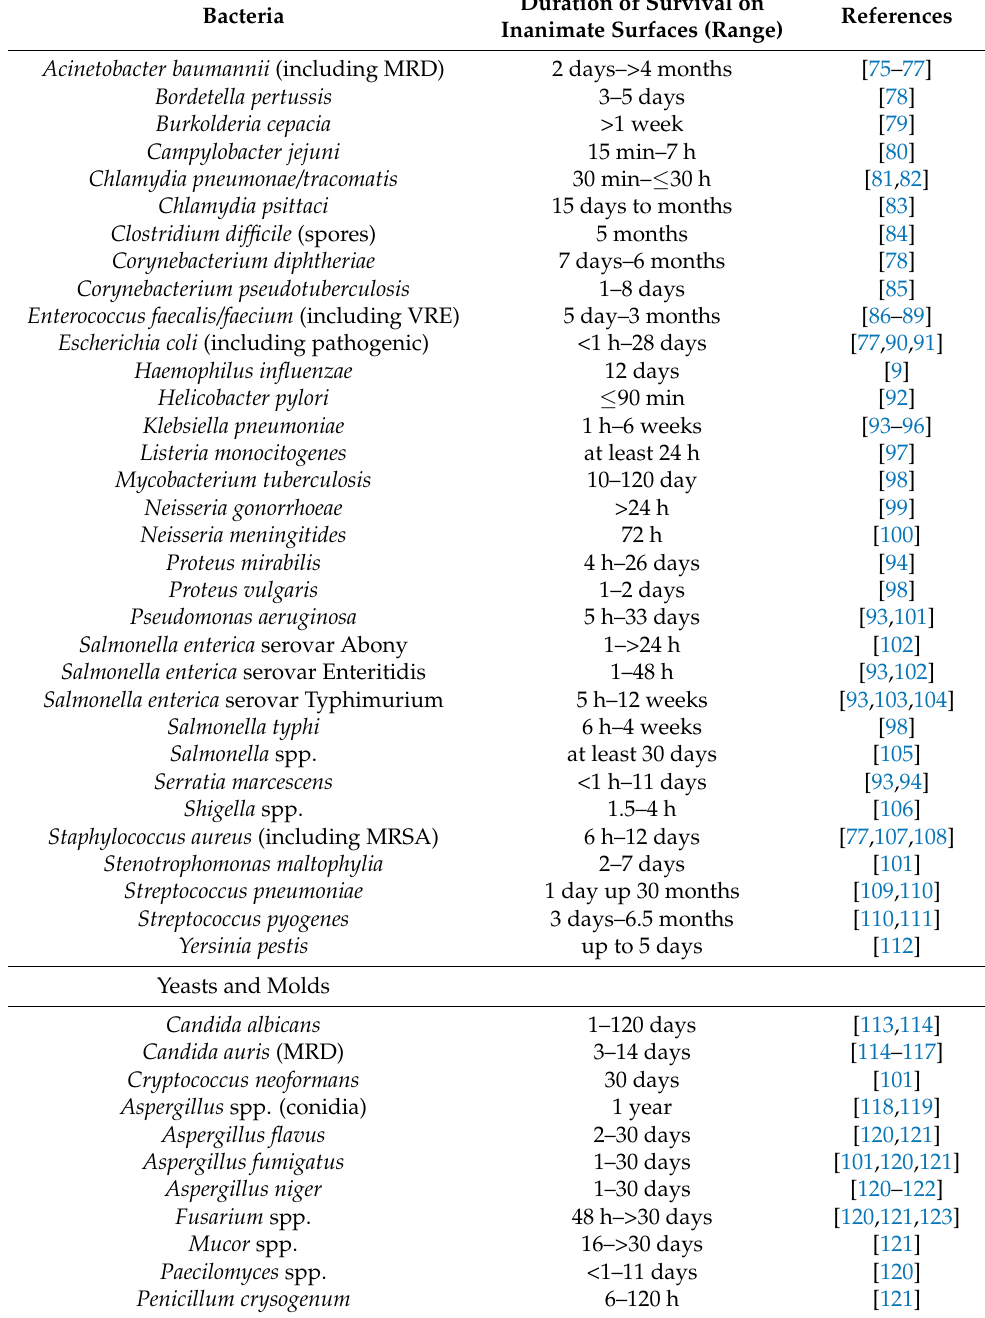
Table 1. Pathogenic bacteria and fungi detected in fomites and hospital environments, their survival and